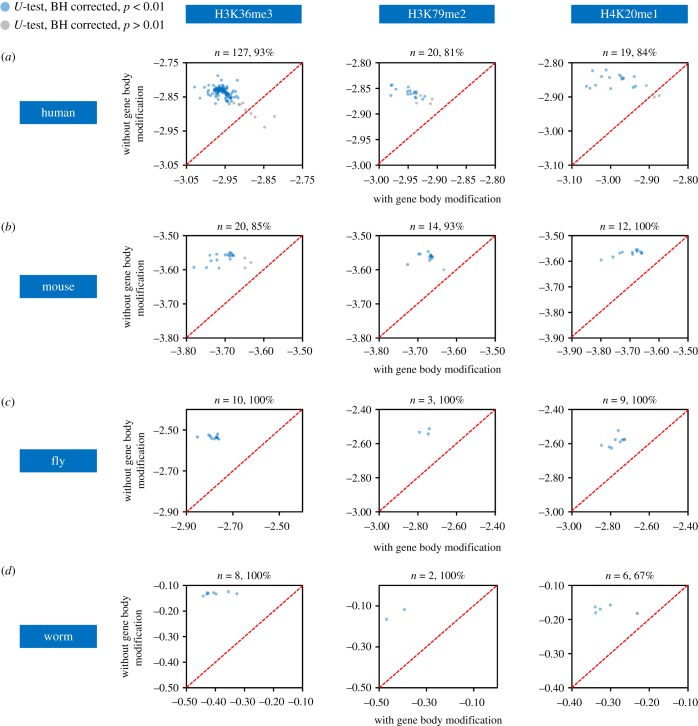
Genes enriched for gene body H3K36me3, H3K79me2 and H4K20me1 modifications exhibit restricted expression plasticity. (a–d) Gene body H3K36me3, H3K79me2 and H4K20me1 modifications restrict GEP in four species. Each scatterplot shows median GEP for genes with (X-axis) or without (Y-axis) a histone modification in the gene body region. Samples showing significant difference (Mann–Whitney U-test, Benjamini–Hochberg (BH) corrected p < 0.01) are indicated in blue. Diagonal line indicates equal GEP. The number of samples analysed and the percentage of samples with consistent differences are shown above each scatterplot.